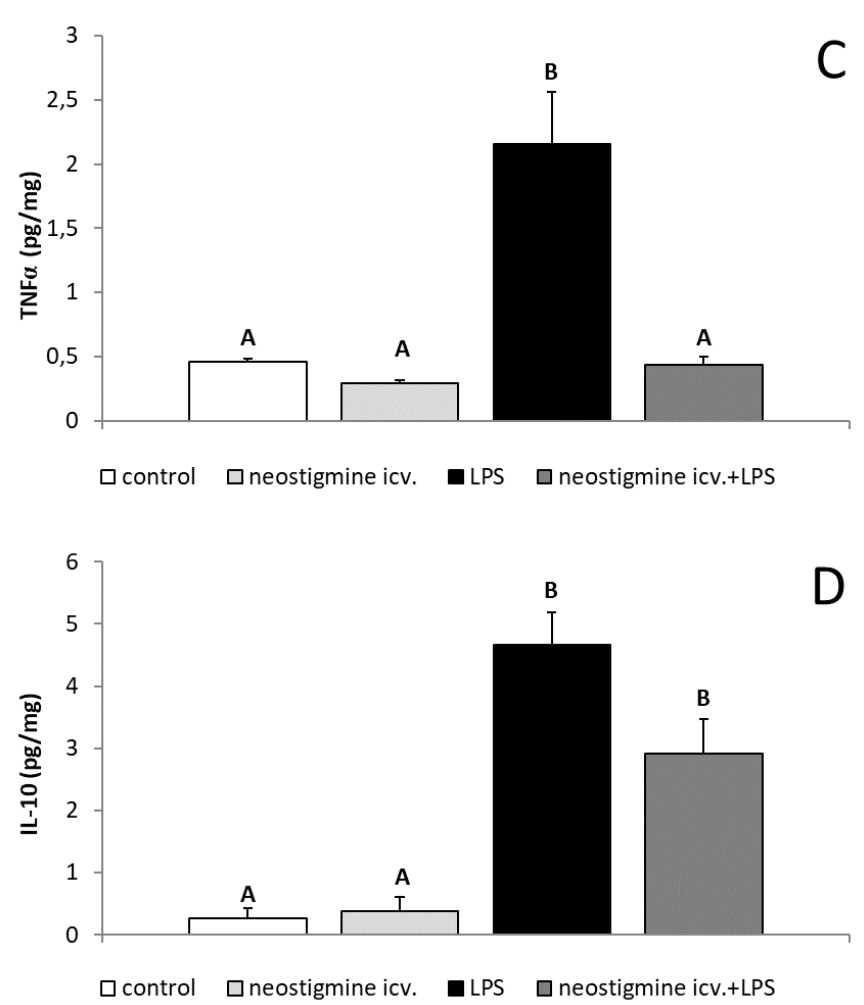
Figure 5. E ff ect of lipopolysaccharide (LPS; 400 ng / kg; intravenous) and neostigmine (1 mg / animal; intracerebroventricular (icv.)) injections on the level (mean ± S.E.M.; n = 6 animals per group) of pro-inflammatory cytokines: interleukin (IL)-1 β ( A ), IL-6 ( B ), tumor necrosis factor (TNF) α ( C ), and IL-10 ( D ) in the preoptic area of the hypothalamus of ewes during the follicular phase of the estrous cycle. The data are presented as the mean value ± S.E.M. ( n = 6 animals per group). The results were analyzed using a two-way ANOVA. Significant di ff erences marked with di ff erent capital letters